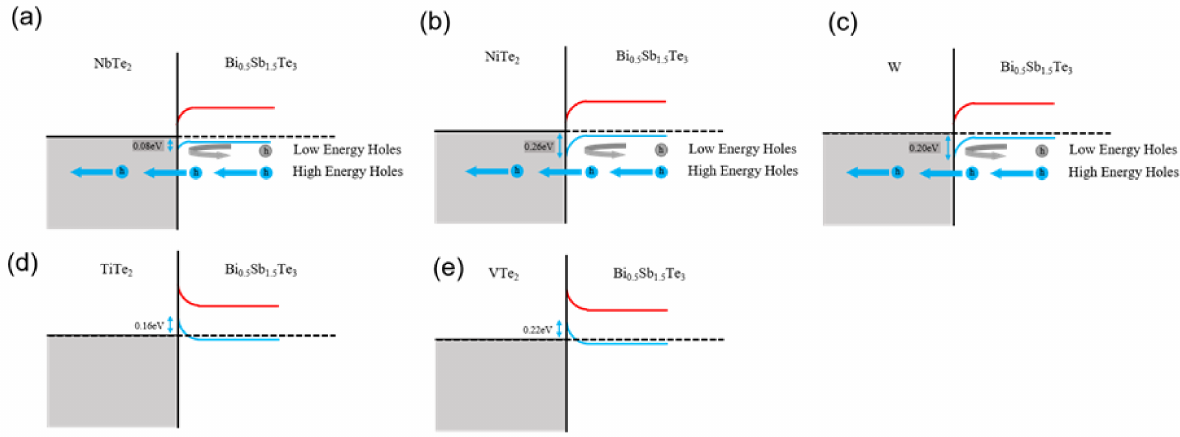
Figure 2. Band alignments at heterointerfaces between Bi 0.5 Sb 1.5 Te 3 and secondary phases (NbTe 2 , NiTe 2 , W, TiTe 2 , and VTe 2